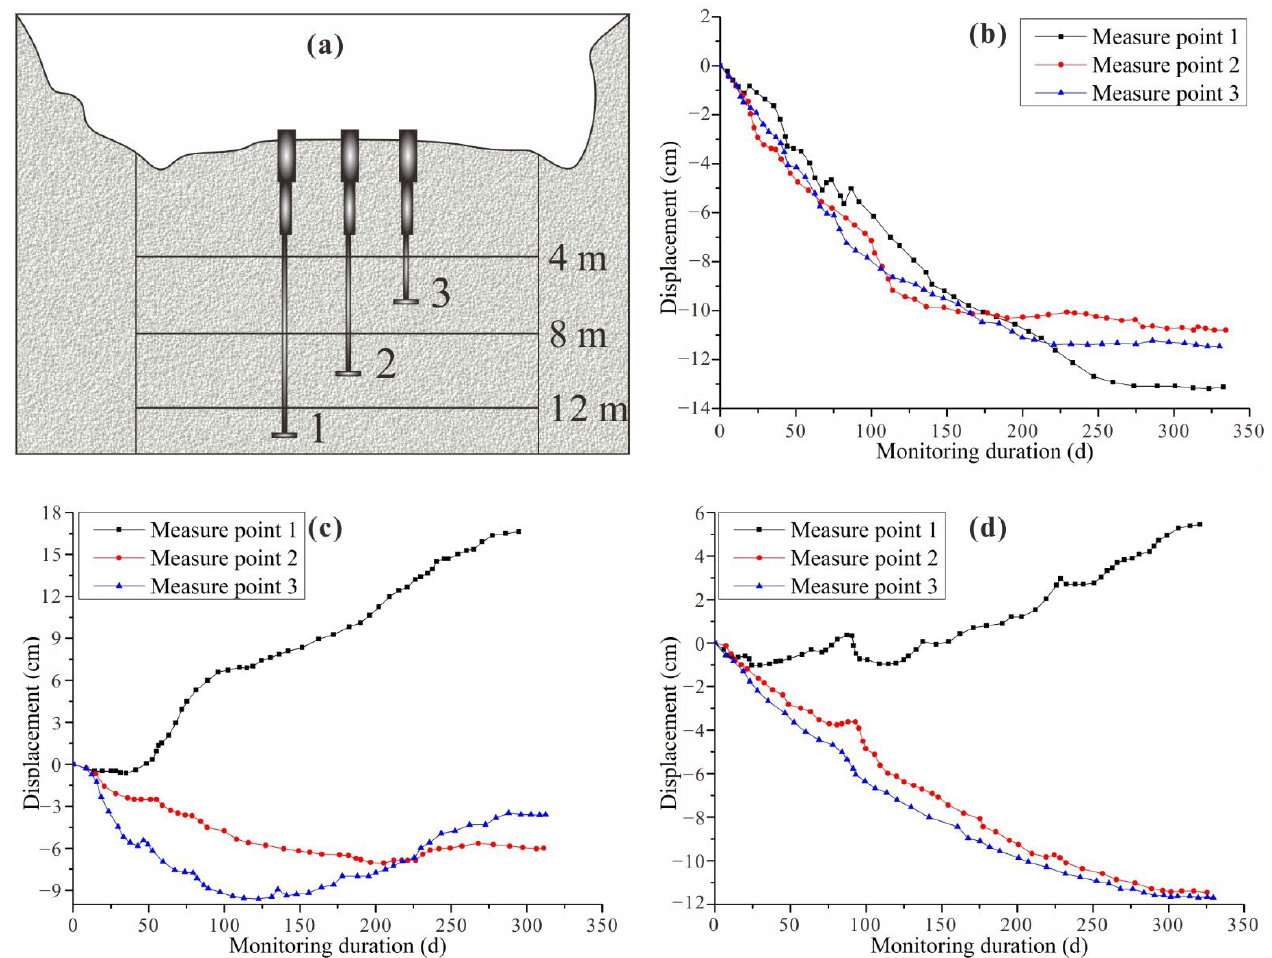
Figure 4. In situ deformation monitoring of the backfill. ( a ) Distribution of the displacement sensors; ( b ) Monitoring results of line 42; ( c ) Monitoring results of line 44; ( d ) Monitoring results of line 46.